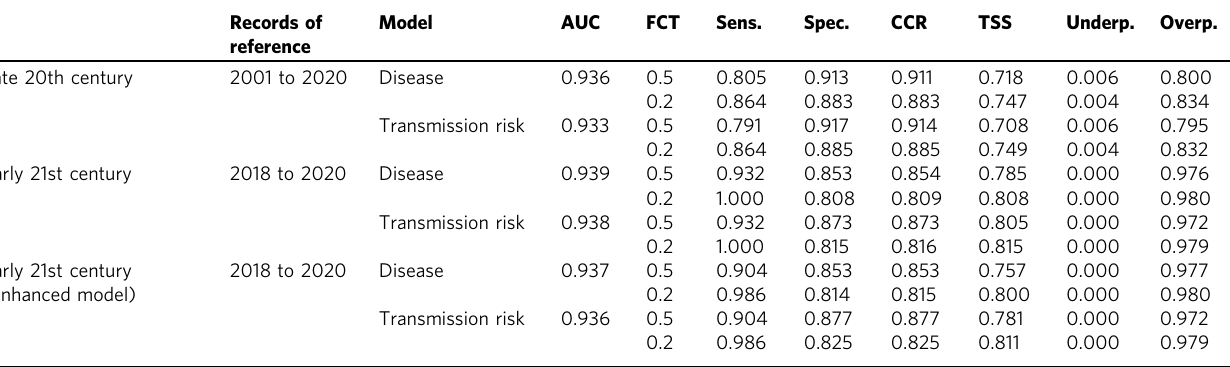
Table 2 Validation of model predictive capacity based on discrimination and classi fi cation performance respect to yellow fever records of a later